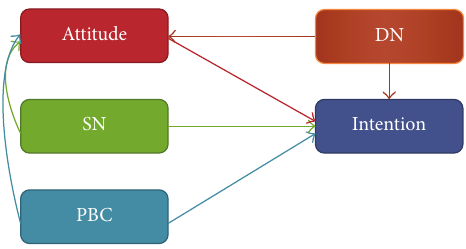
Figure 3: Impact of PBC on attitude.